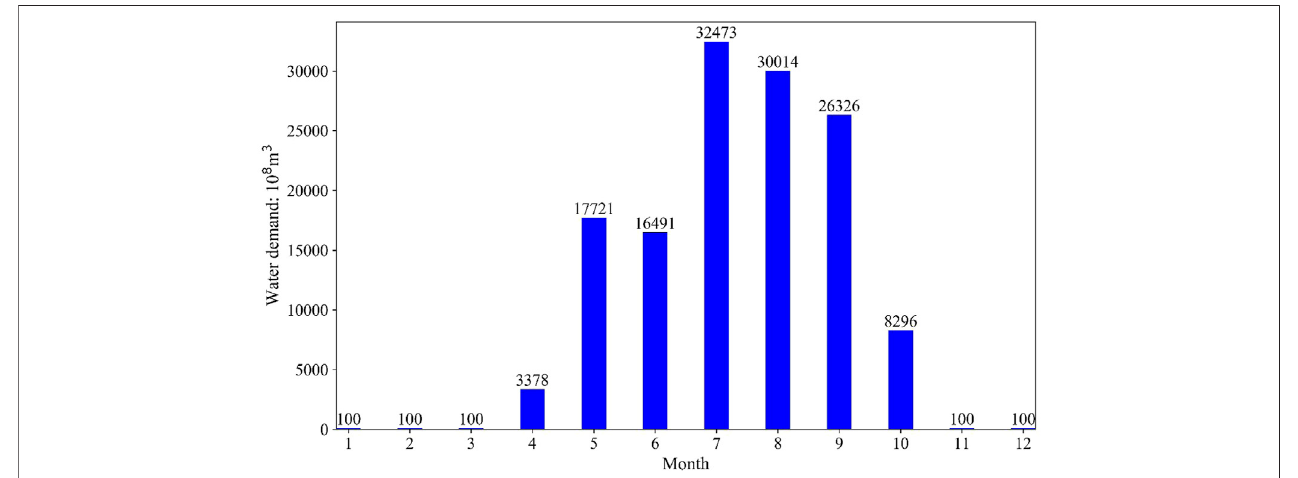
FIGURE 8 | Monthly demand for domestic and irrigation water in the Dongting Lake